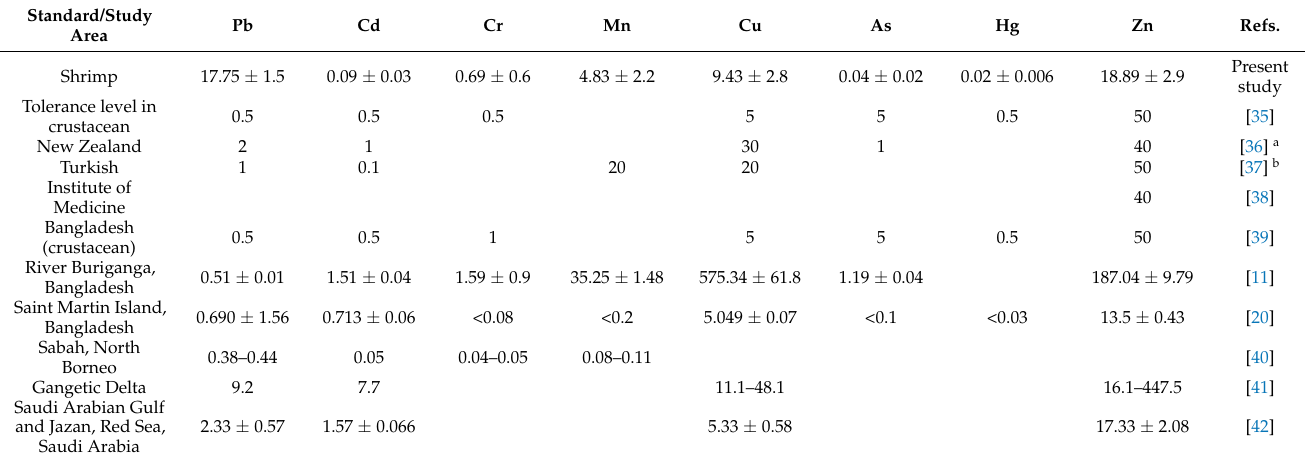
Table 1. Comparison of heavy metals (Mean ± SD) in the shrimp muscle tissue samples with various standard levels and relevant study (mg/kg wet